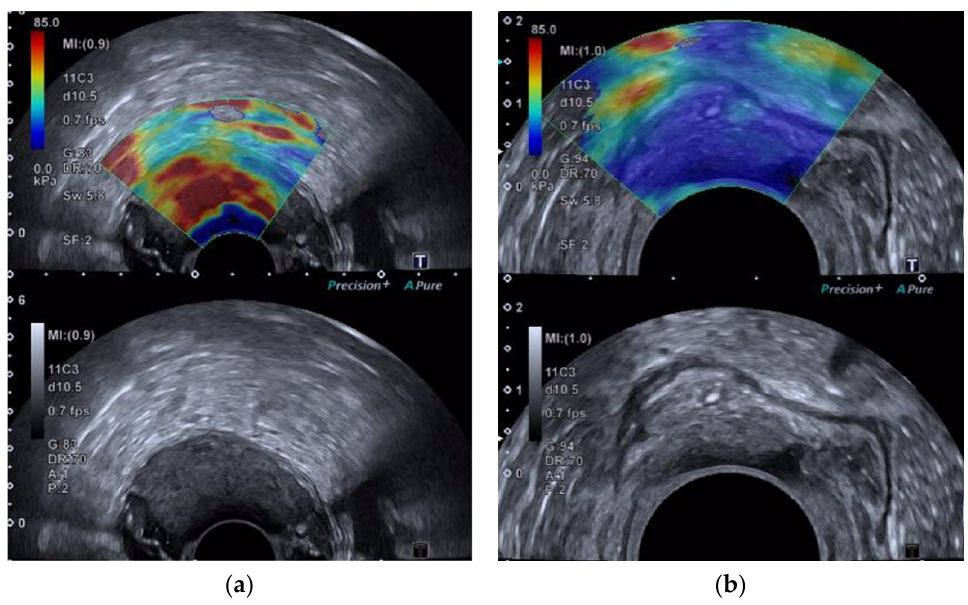
Figure 1. Shear wave elastography images of ( a ) a malignant rectal tumor pT3 and ( b ) a benign rectal polyp. Images are shown on a shared screen with a B-mode image overlaid with a color-coded map where red and yellow represent hard elastography values and blue and green represent soft tissue values. The corresponding B-mode is shown in the lower image.